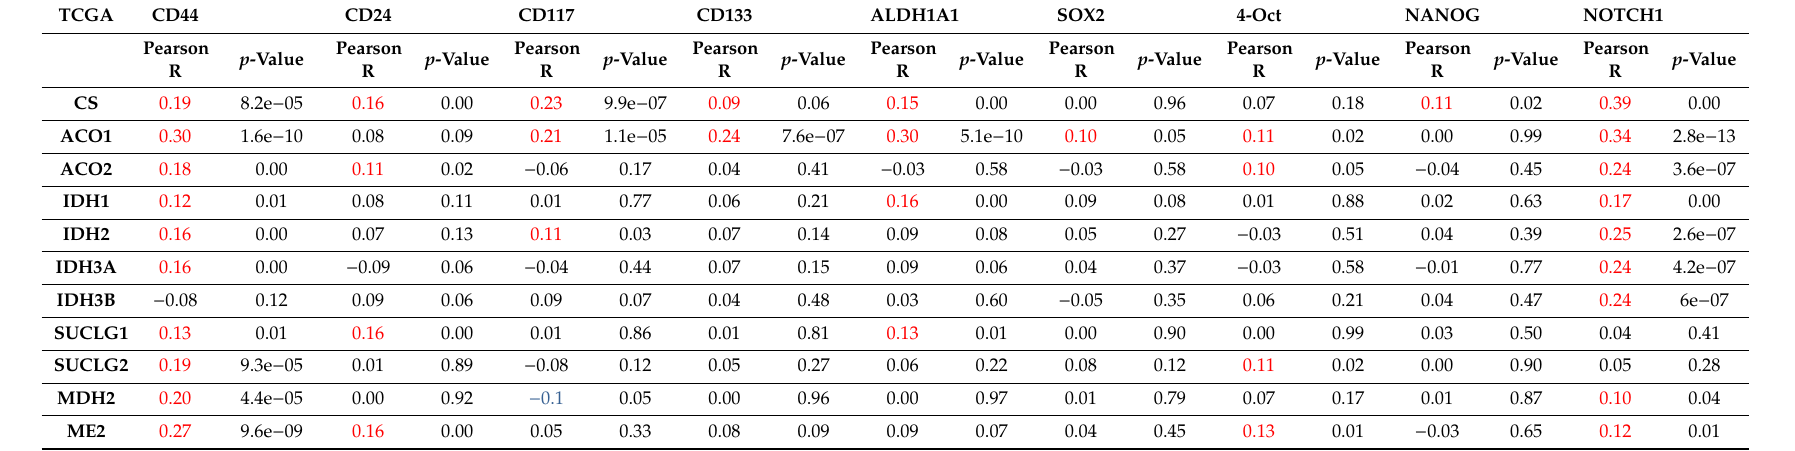
Table 2. Correlation of OCSC markers with TCA enzymes in TCGA. Pearson Correlation between the expression of CSC transcripts and the transcripts of the key TCA enzymes in ovarian cancer specimens from TCGA and curated from GEPIA. Red indicates significant positive, blue indicates negative correlations, and black indicates insignificant p -values of either positive or negative